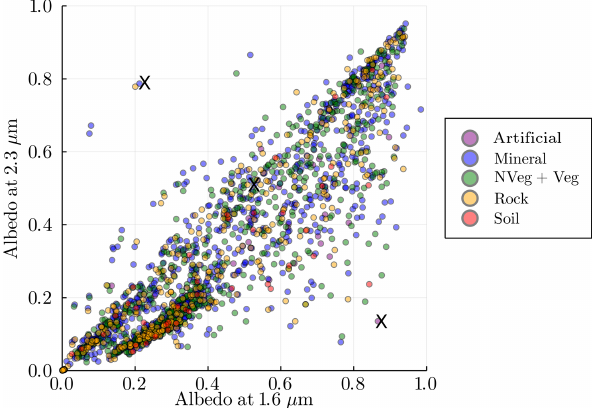
Figure 7. A plot showing precision errors from the CH 4 column retrieval in the 1.6µm band (dotted) and the 2.3µm band (solid) over three distinct surfaces (colored), using instruments with different FWHM (in the unit of molem − 2